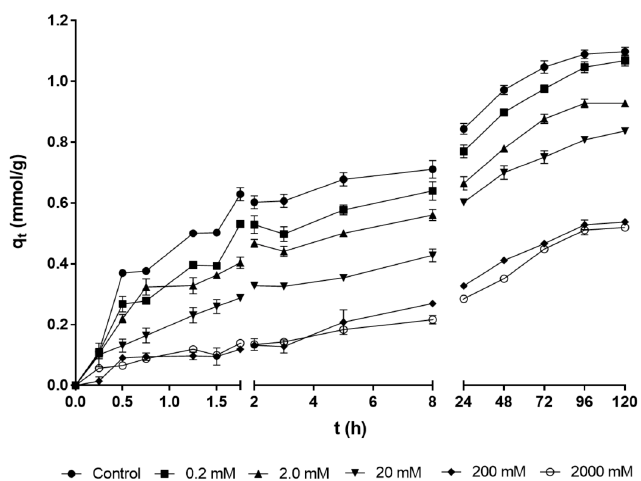
Figure 1. E ff ect of the NaCl ionic strength on the biosorption of Ni 2 + by acorn shell of Quercus crassipes Figure 1. Effect of the NaCl ionic strength on the biosorption of Ni 2+ by acorn shell of Quercus crassipes Humb. & Bonpl. (QCS). Humb. & Bonpl. (QCS).